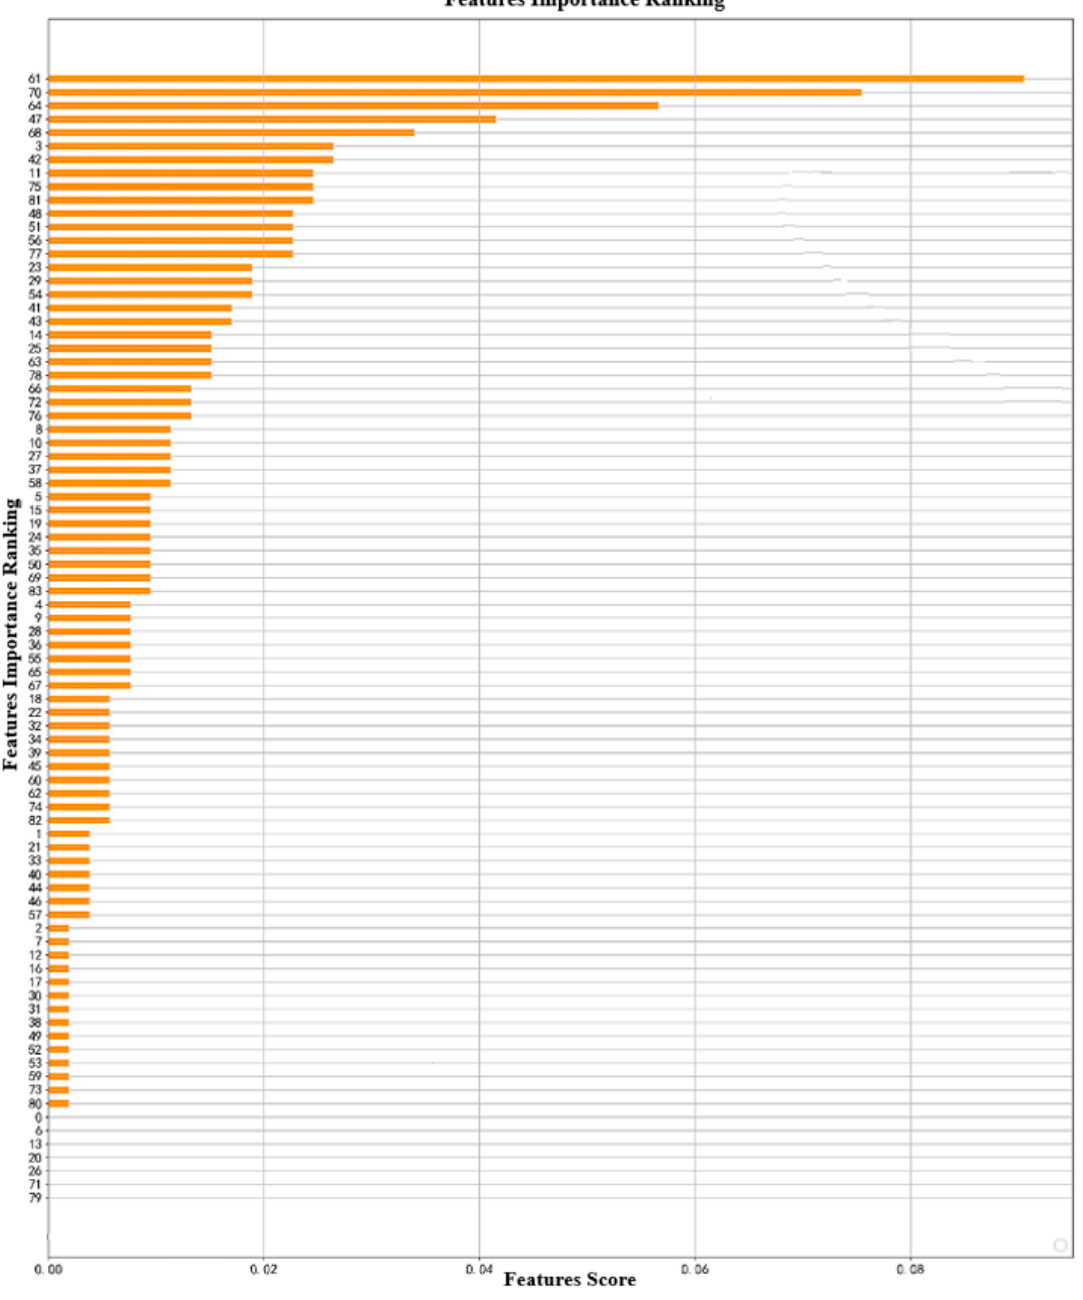
Figure 6. Feature weighting of XGBoost.